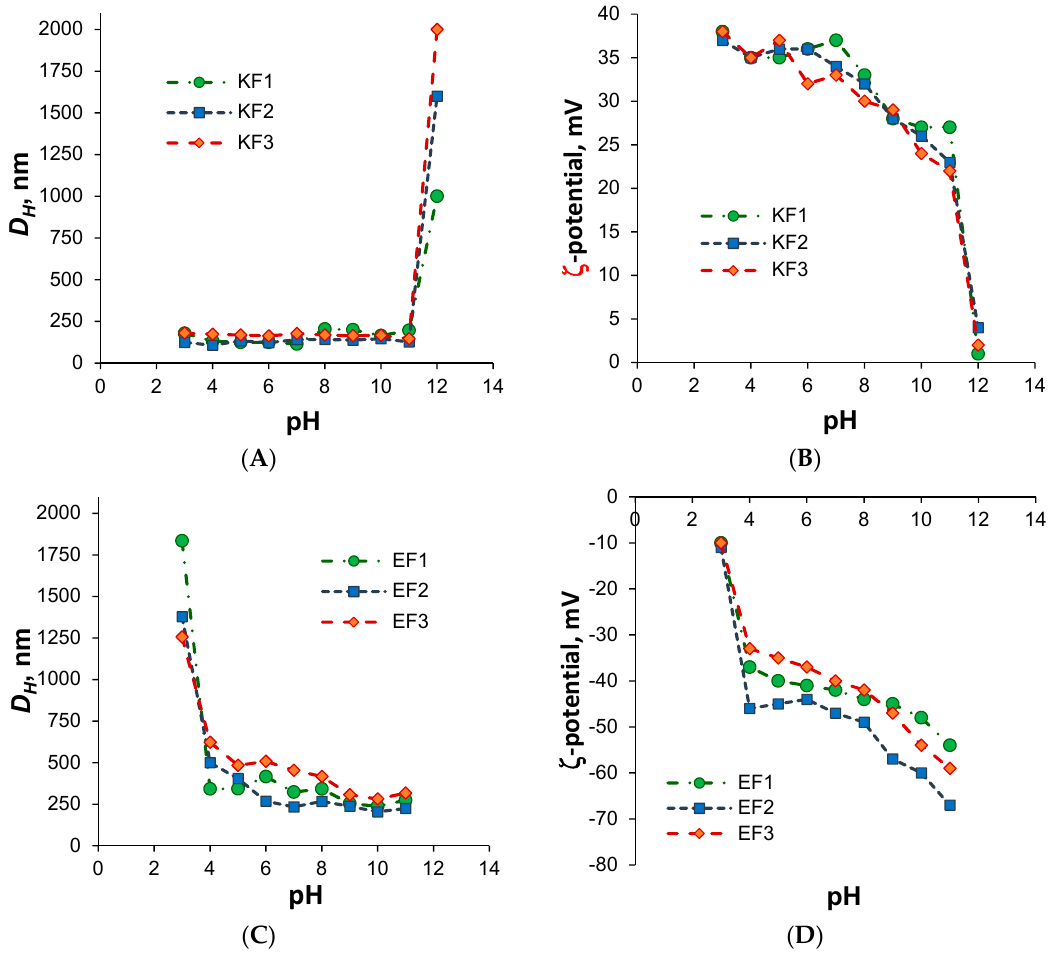
Figure 2. Dependence of hydrodynamic diameter and ζ -potential of polypeptide nanospheres on pH: ( A , B )—P(Lys- co - D Phe); ( C , D )—P(Glu- co - D Phe).